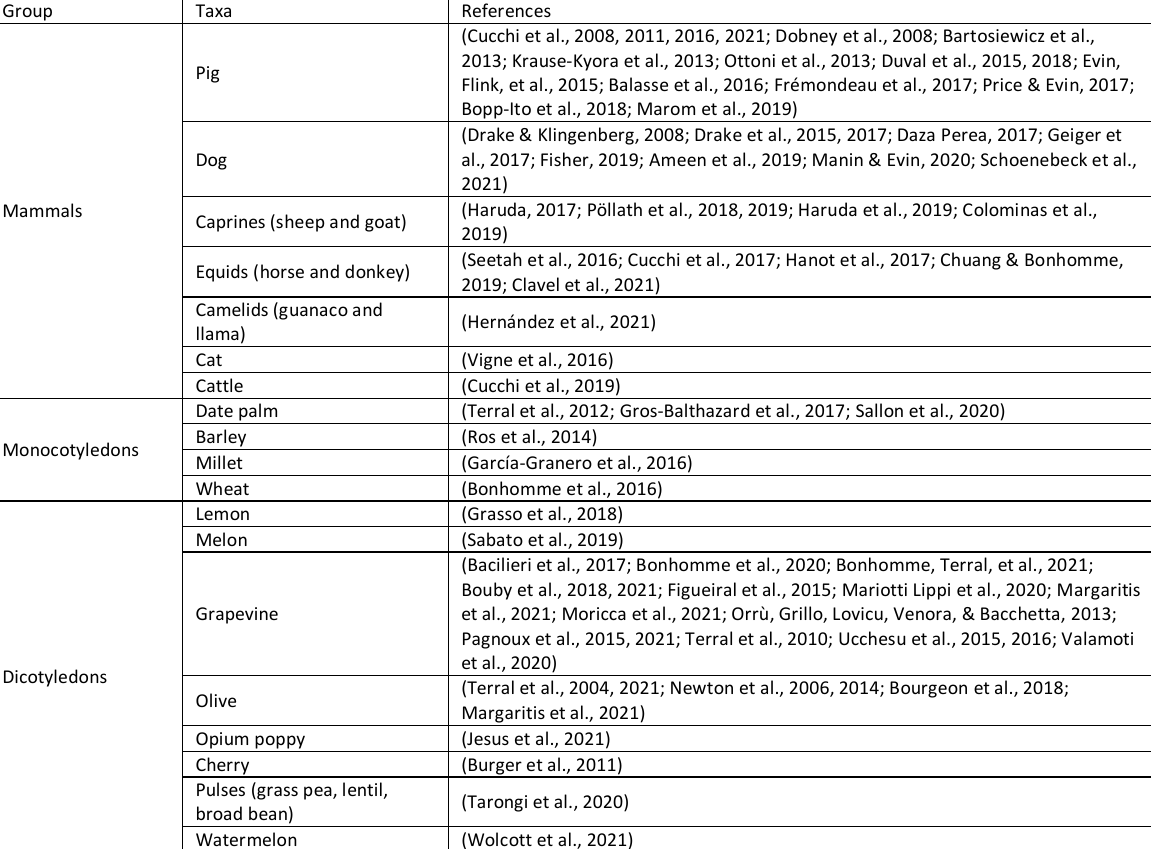
Table 1. List of the reviewed publications. An extended version of the table, including research themes, employed methodology, and combination with biomolecular markers can be found in SI-table 1.